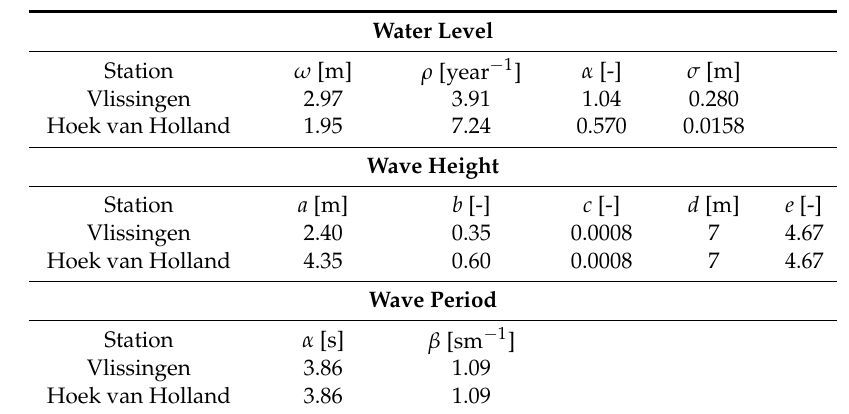
Figure 6. Hydraulic boundary conditions during a storm. The top plot shows the total water level (solid black line), composed of the tide (dashed blue line) and surge (dashed red line). The middle plot shows the significant wave height (solid black line) and this wave height divided into one-hour sections (dashed blue line). The bottom plot shows the same for the wave peak period. Here, the tidal peak coincides with the surge peak. Storm shape based on Steetzel et al. [42]. Table 2. Statistical parameters for water level, wave height and wave period during a storm [42]. α is a shape parameter [-], ω is a threshold above which the conditional Weibull function is valid [m], σ is a scale parameter [m] and ρ is the frequency of exceedance of the threshold level ω [year − 1 ]. a [m], b [-], c [-], d [m] and e [-] are statistical parameters. α [s] and β [sm − 1 ] are statistical parameters as well. All parameters taken from Steetzel et al.